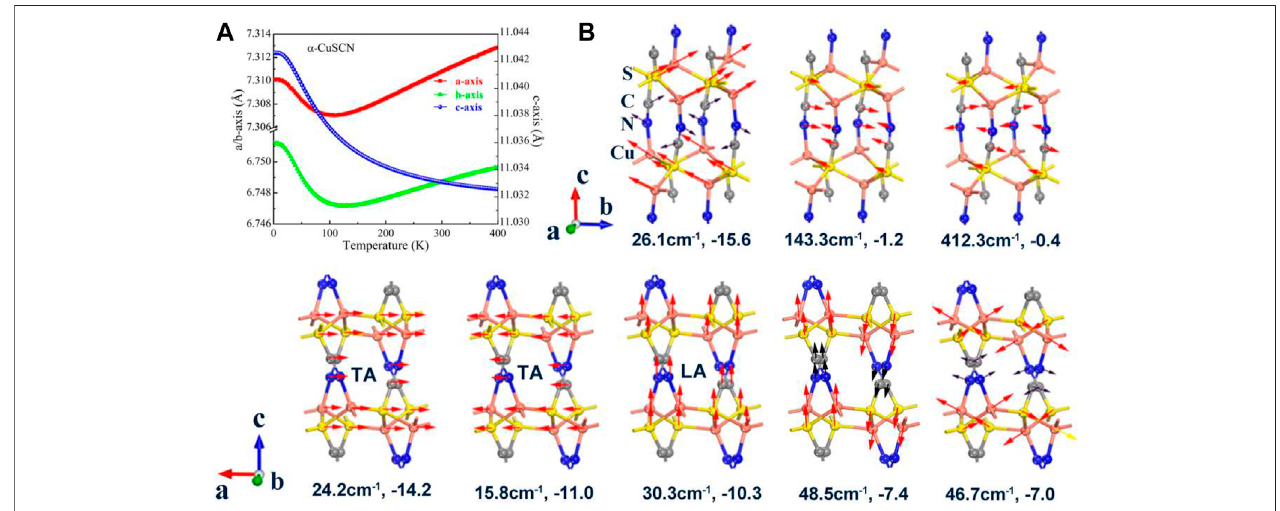
FIGURE4| (A) Temperature dependence oflattice parametersin thetemperaturerange of0 – 400 K for β -CuSCN. (B) Six representative low vibration modes with negative Grüneisen parameters of the phase. The frequency and the corresponding Grüneisen parameter are given for each mode.